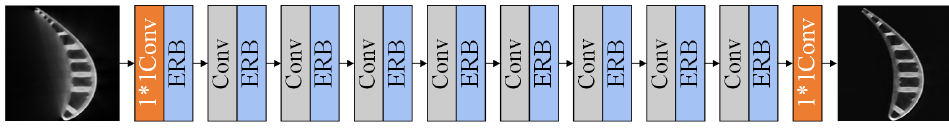
Figure 6. The structure of the enhanced residual network for ICT images artifact removal.